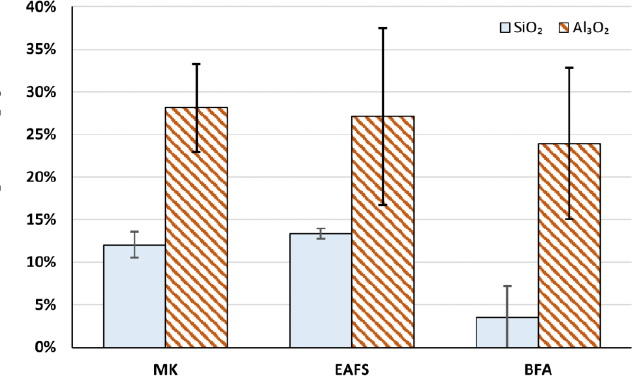
Figure 6. Dissolved SiO 2 and Al 2 O 3 reported as a fraction of the total amount measured by XRF.